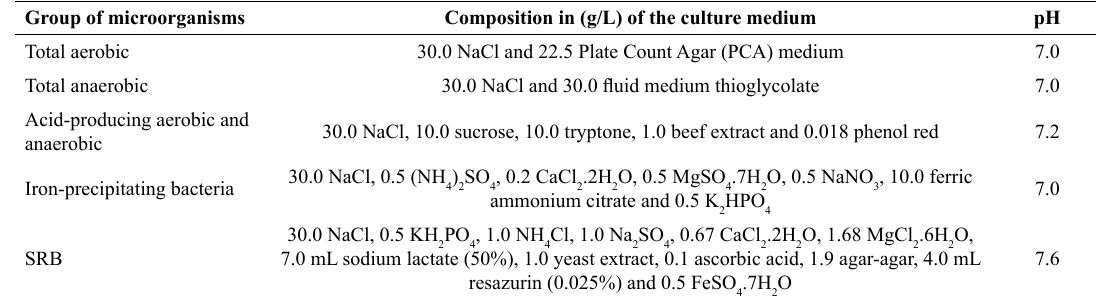
Table 1. Composition of the culture medium of different groups of microorganisms. Group of microorganisms